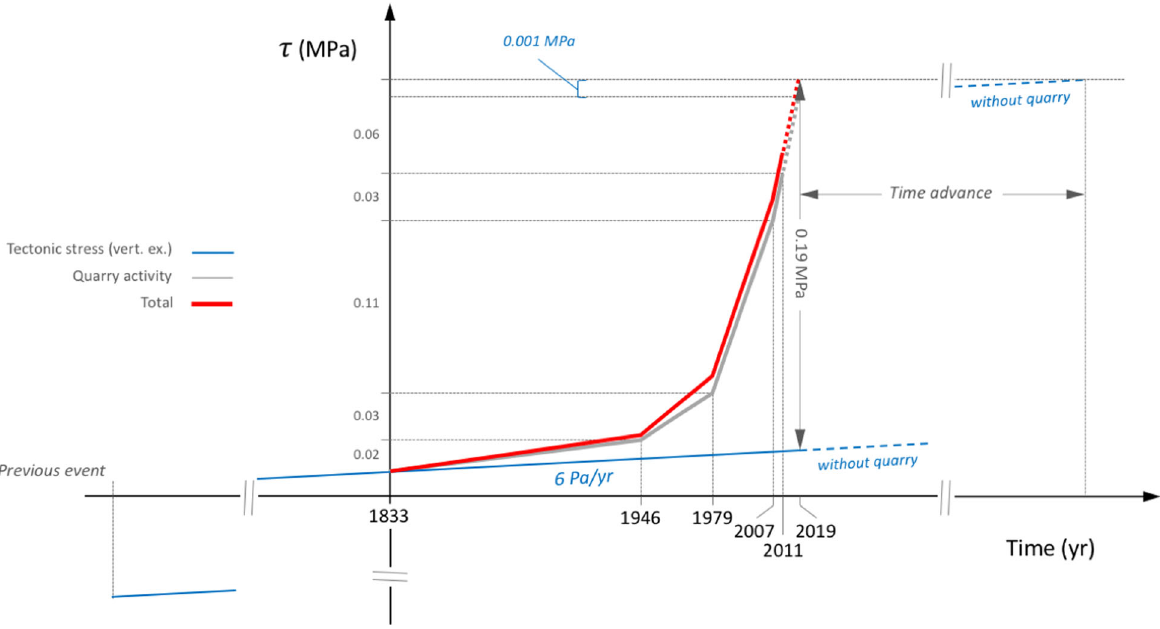
Fig. 4 Stress progression on the main fault. The increment of the shear stress on the faults of the 2019 earthquake caused by the tectonic forces (blue line; exaggerated vertical scale), starting from the previous (unknown) earthquake, and by the Le Teil quarry activity (0.19 MPa; gray line). The anthropogenic shear stress is computed at the point marked by the small black square in Fig. 3. The total shear stress on the fault is represented by the red line. The horizontal gray line on top marks the fault